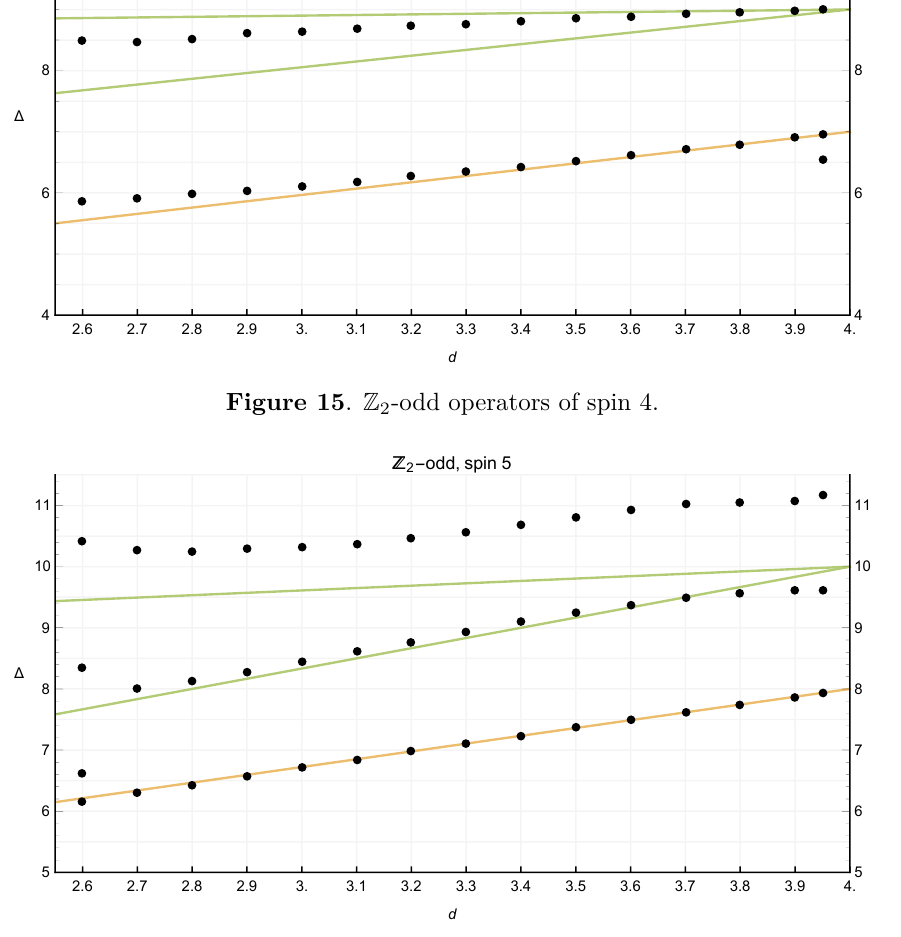
Figure 16 . Z 2 -odd operators of spin